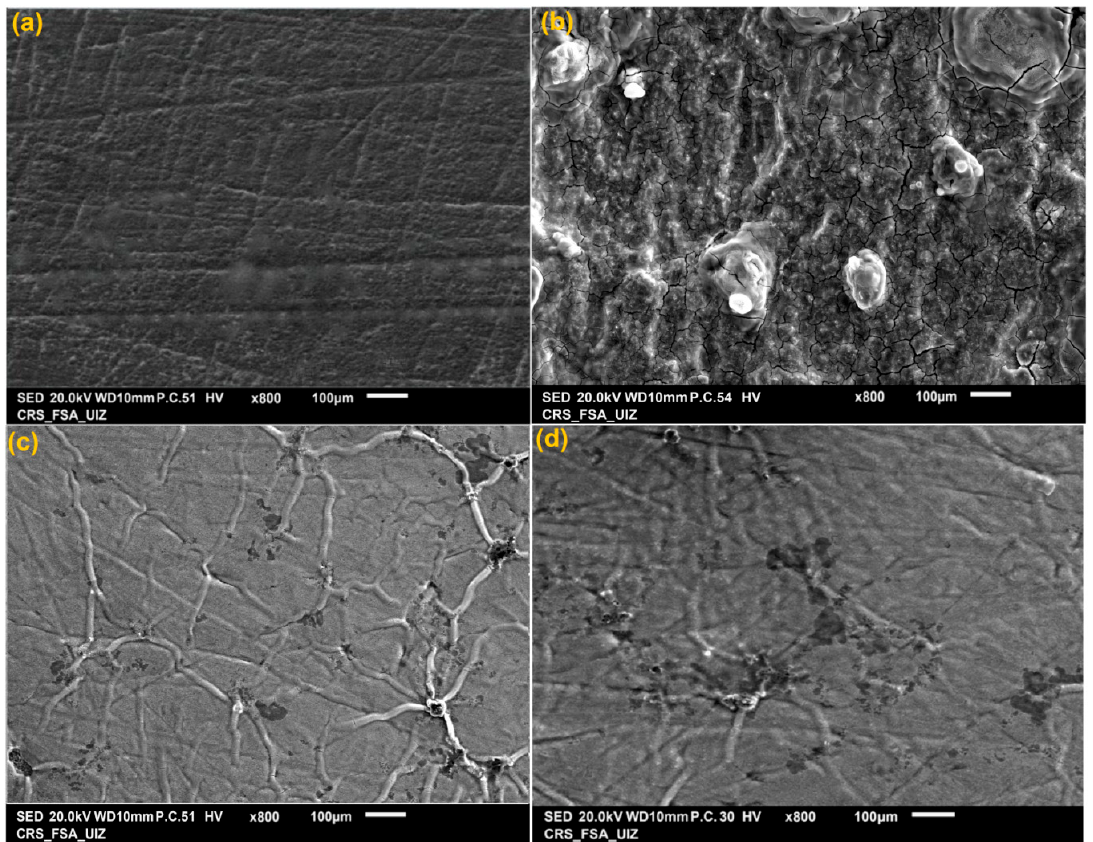
Figure 6. SEM micrographs of mild steel corroded for specimens after 24 h of immersion: polished state ( a ), exposed to 1.0 mol / L HCl solution ( b ), exposed to 1.0 mol / L HCl solution containing 5 × 10 − 3 M of Q2 ( c ) and Q1 ( d ) for 24 h of immersion at 303 K.